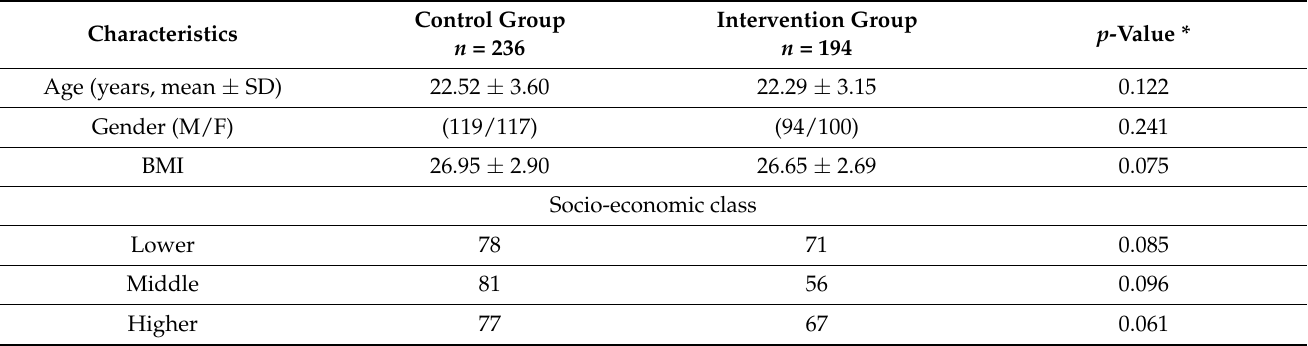
Table 1. Participants’ baseline